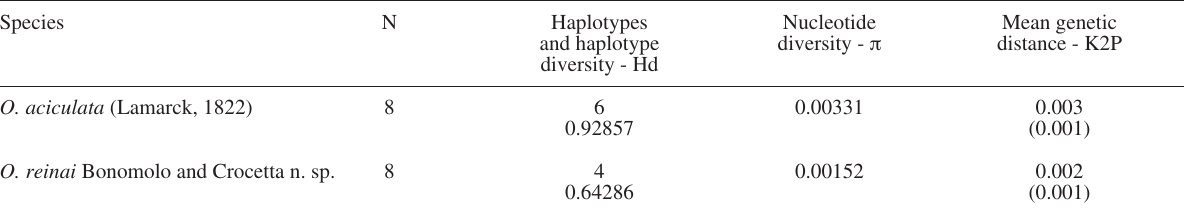
Table 2. – DNA diversity in sympatric samples of Ocinebrina aciculata and O. reinai